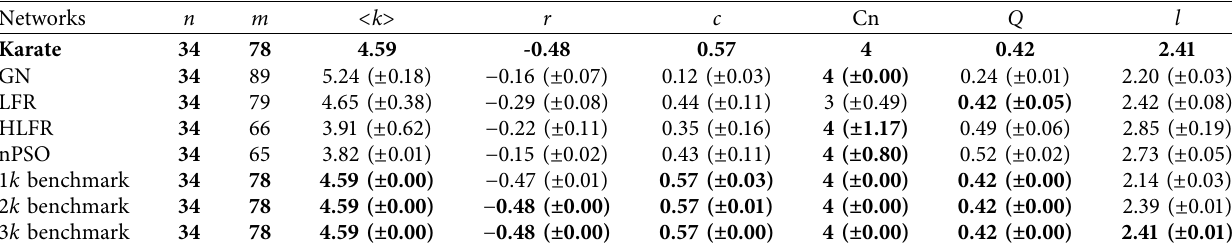
Table 1: Structural characteristics of the original Karate network and seven kinds of generated benchmarks. Each data represents the average value of the characteristic calculated on 100 generated benchmarks and the data in parentheses represents the corresponding standard deviation. Note that the best results closest to the original karate network on each characteristic are highlighted in bold.